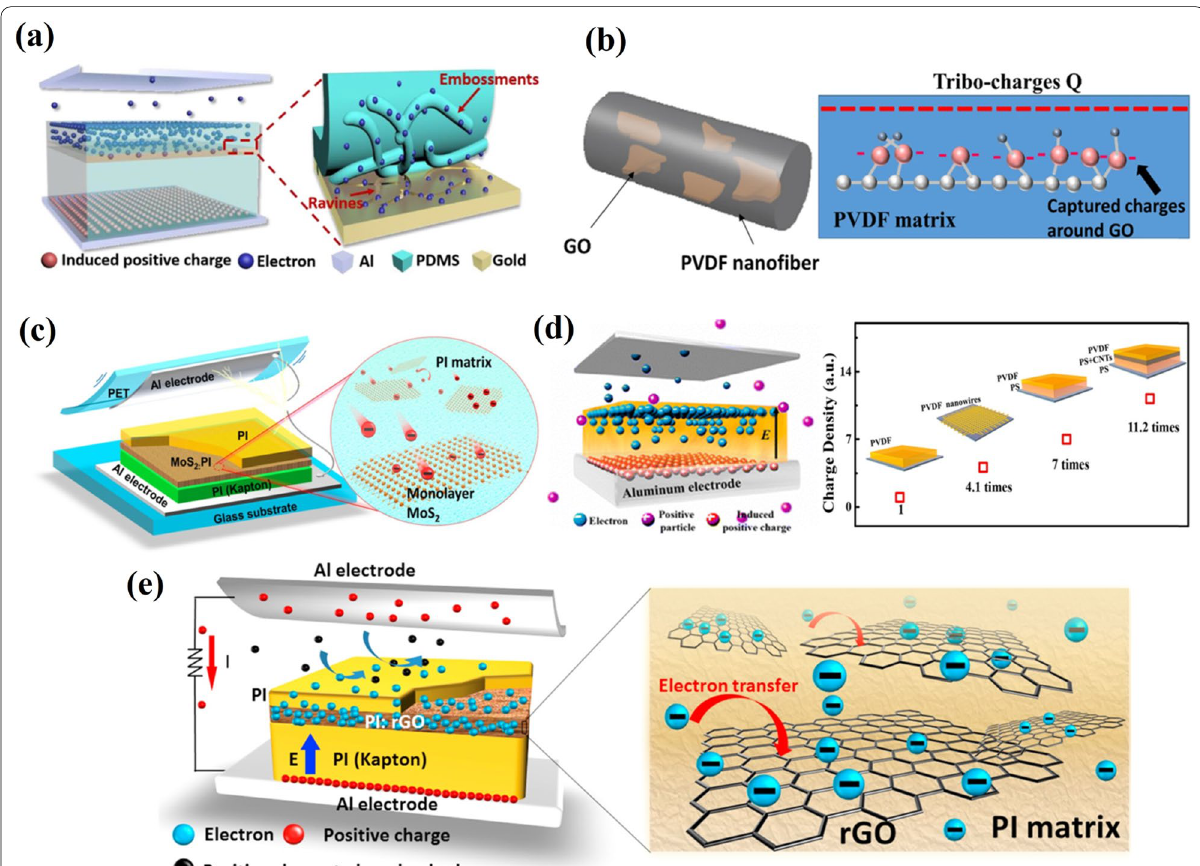
Fig. 15 Different approaches applied for charge trapping. a ) Illustrations of electrons’ drift in G-TENG and the schematic diagram of electrons’ escape from PDMS to the gold (Reproduced with permission from Ref. [91]). b Distribution of GO on a nanofiber and stored charge on the surface of a GO sheet (Reproduced with permission from Ref. [94]). c Illustration of the vertical contact-separation mode TENG with a MoS 2 -monolayer film and a schematic diagram of the electron transfer from the PI layer to the MoS 2 monolayer (Reproduced with permission from Ref. [97]). d Schematic of the transport process of triboelectric electrons in the negative friction layer of a TENG and improvement effects of different composite friction layer structure (Reproduced with permission from Ref. [98]). e Illustration of the vertical contact-separation mode TENG with a PI:rGO film and a schematic diagram of electron transfer from the PI layer to the rGO sheets (Reproduced with permission from Ref.